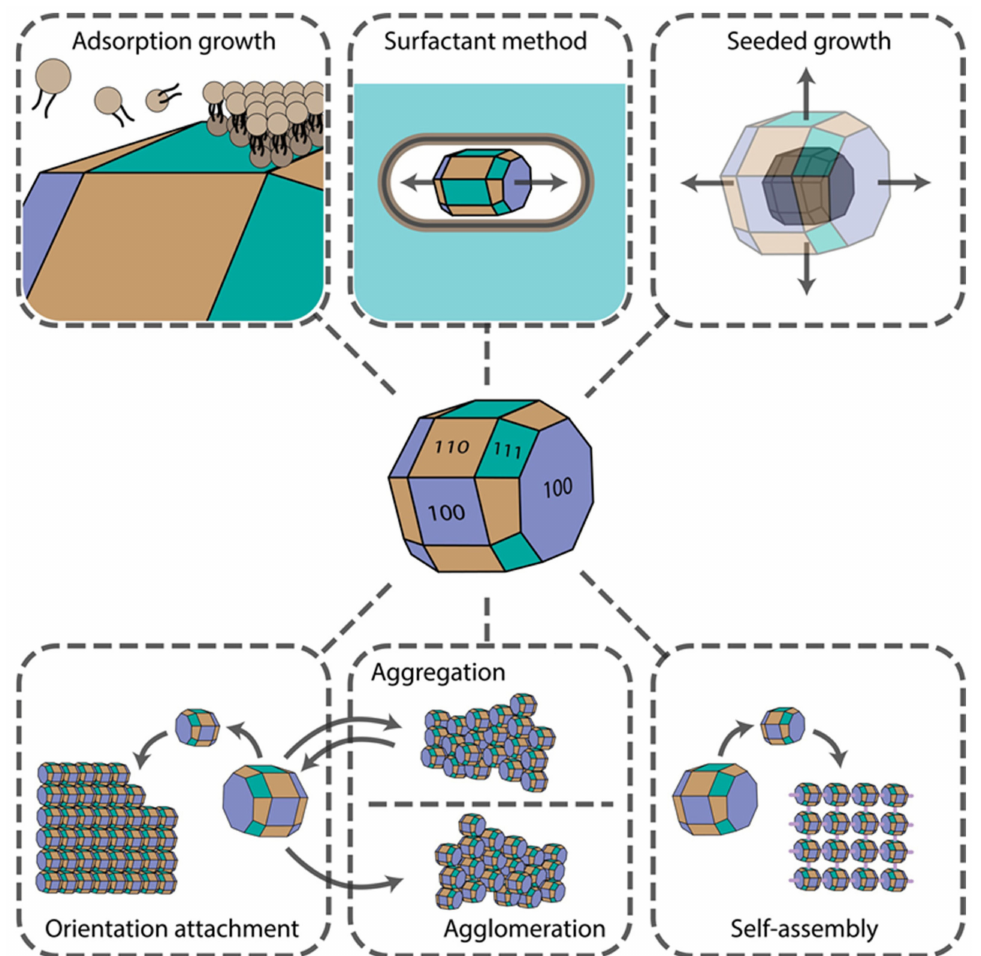
Figure 1. Main mechanisms underlying nanomaterial shape